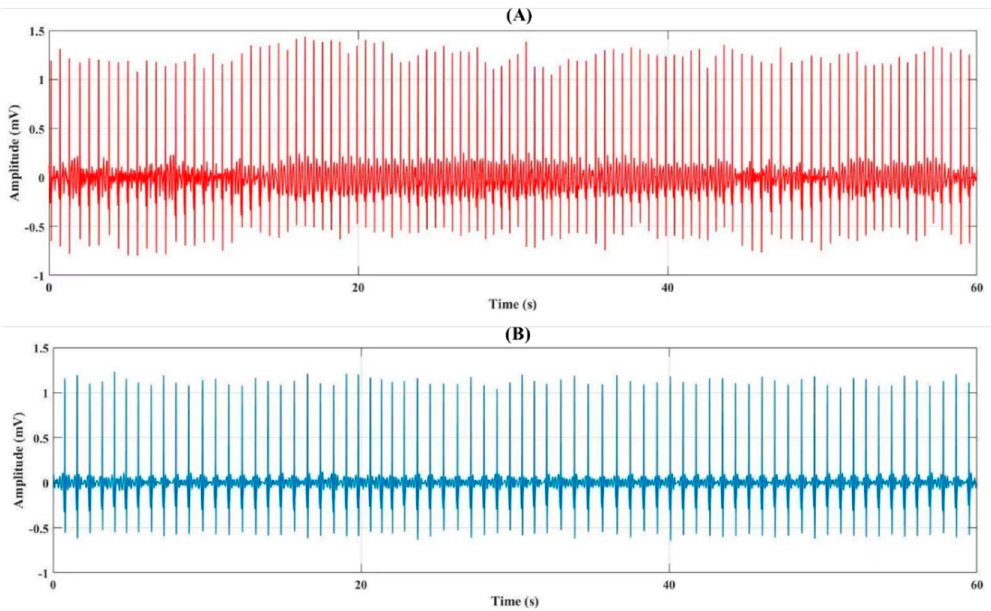
Figure 5. One minute signal representation of the single-lead filtered ECG signal from ( A ) mental stress and ( B ) normal subjects.